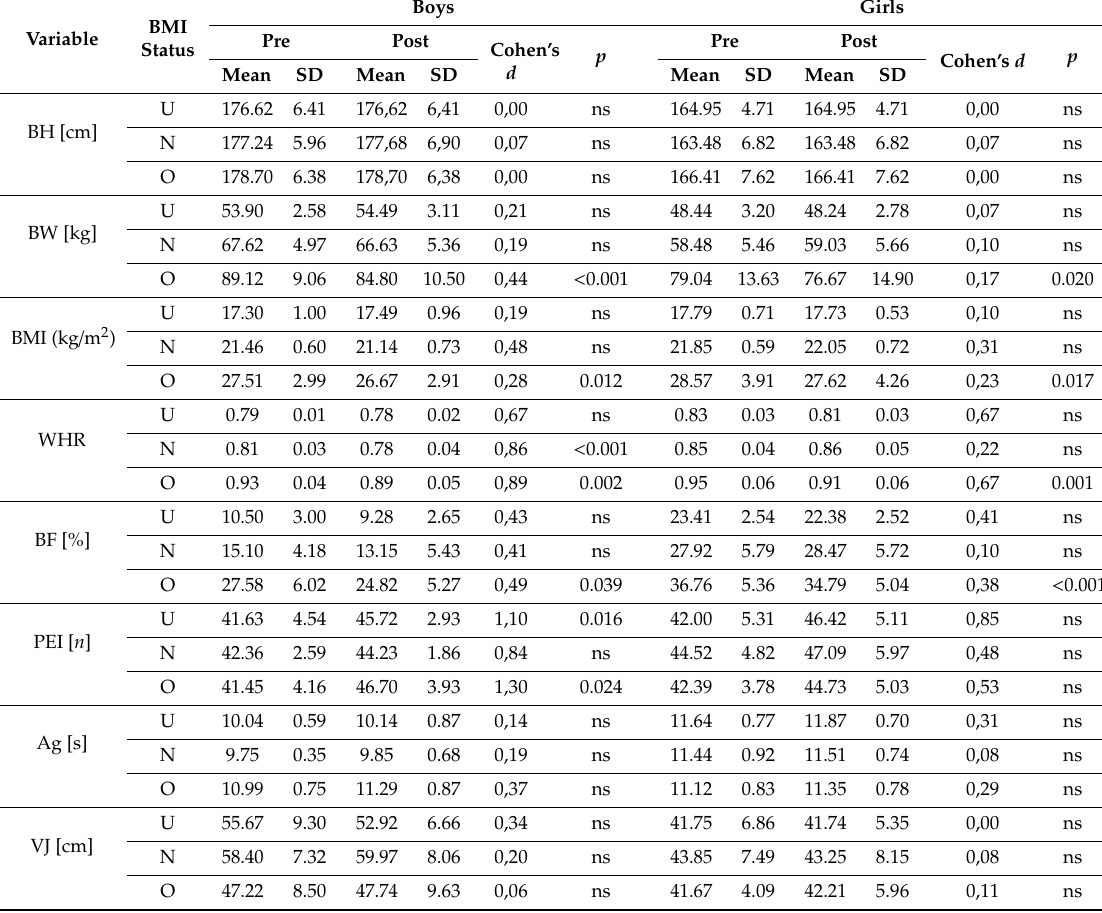
Table 1. Descriptive statistics of the anthropometric, physical e ffi ciency index (PEI), and motor performance measurements and e ff ect sizes and p -values (from Tukey’s test) for di ff erences before and after the 10-week Tabata training (only statistically significant results) in adolescent boys and girls by BMI